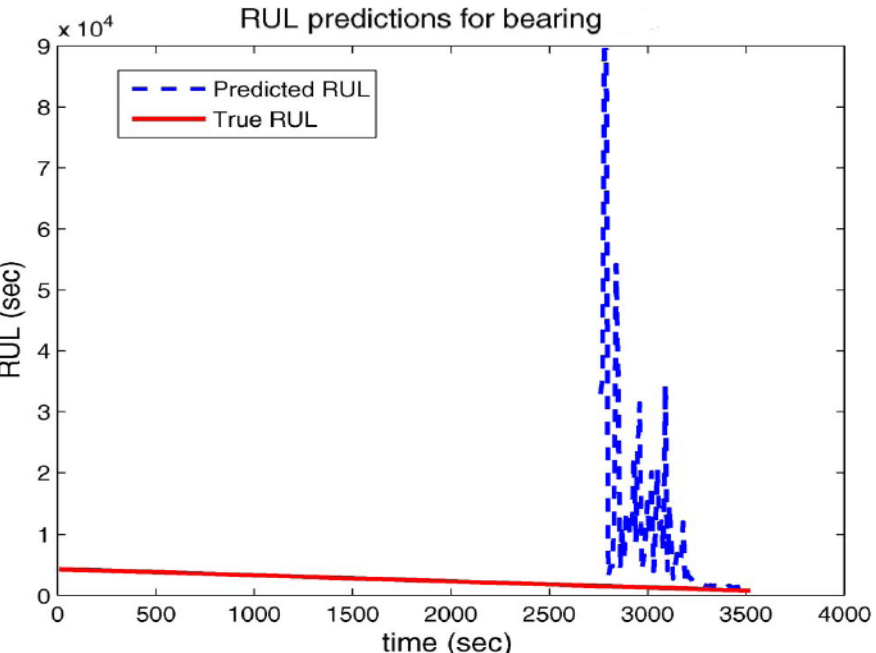
Figure 33. RUL estimation of bearings (RUL prediction versus actual prediction) Reproduced with permission of [82].